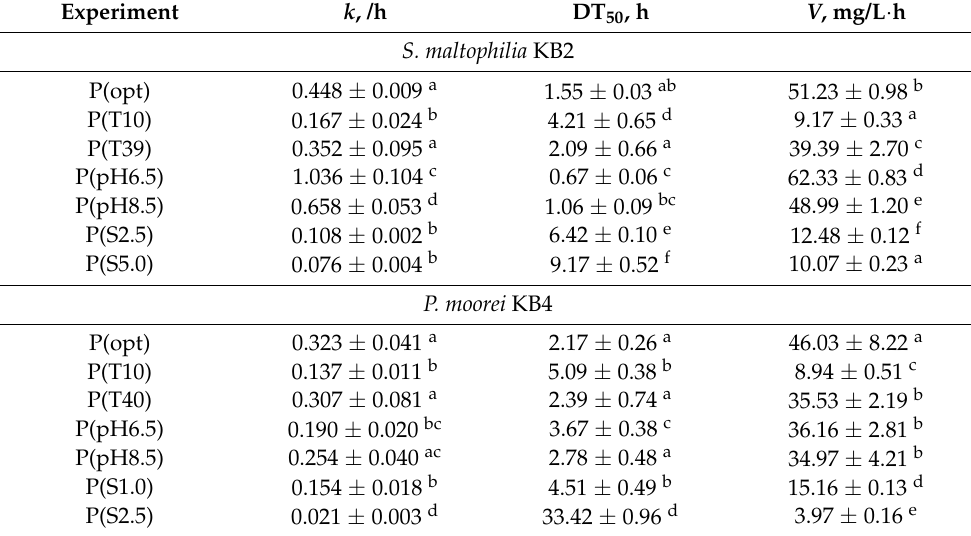
Table 1. The degradation rate constant ( k ), disappearance time of 50% of phenol (DT 50 ), and disap- pearance rate ( V ) of phenol in batch cultures of S. maltophilia KB2 and P. moorei KB4 under different culture